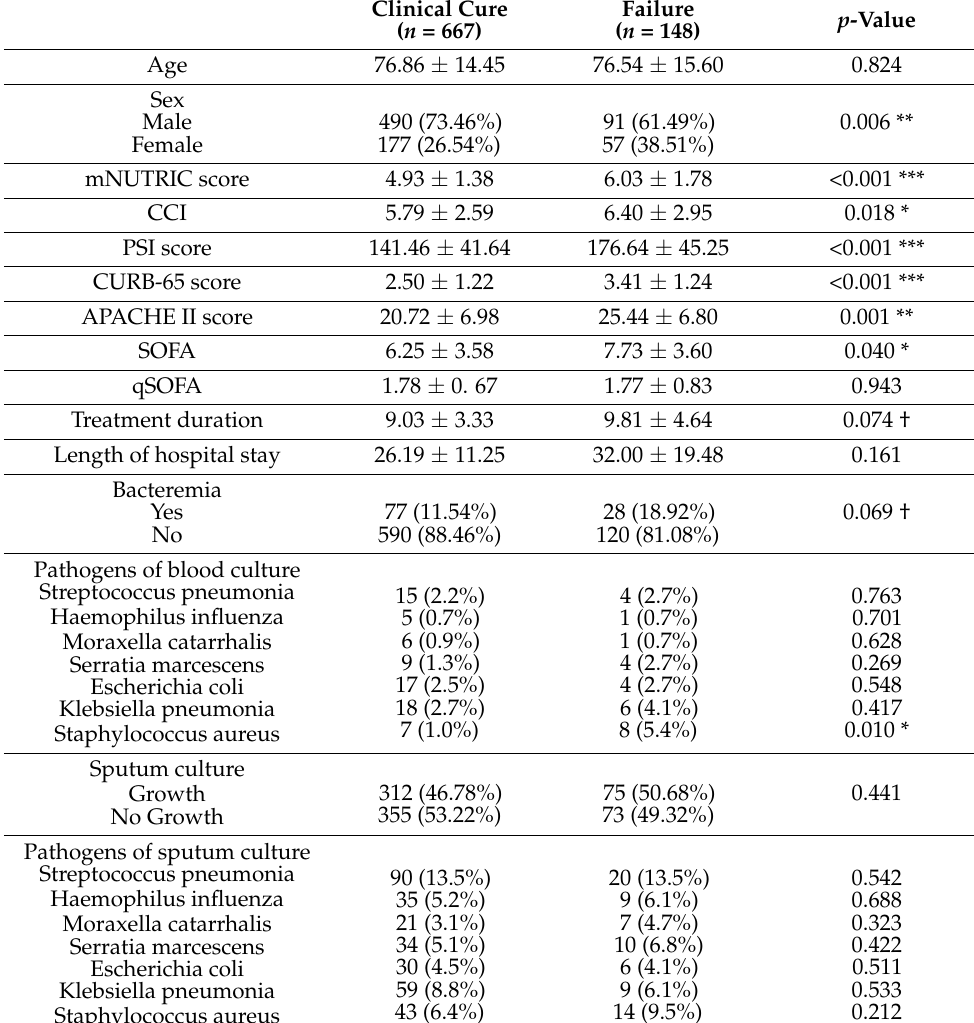
Table 4. Characteristics of clinical prediction rules and clinical factors for predicting treatment outcome in patients with